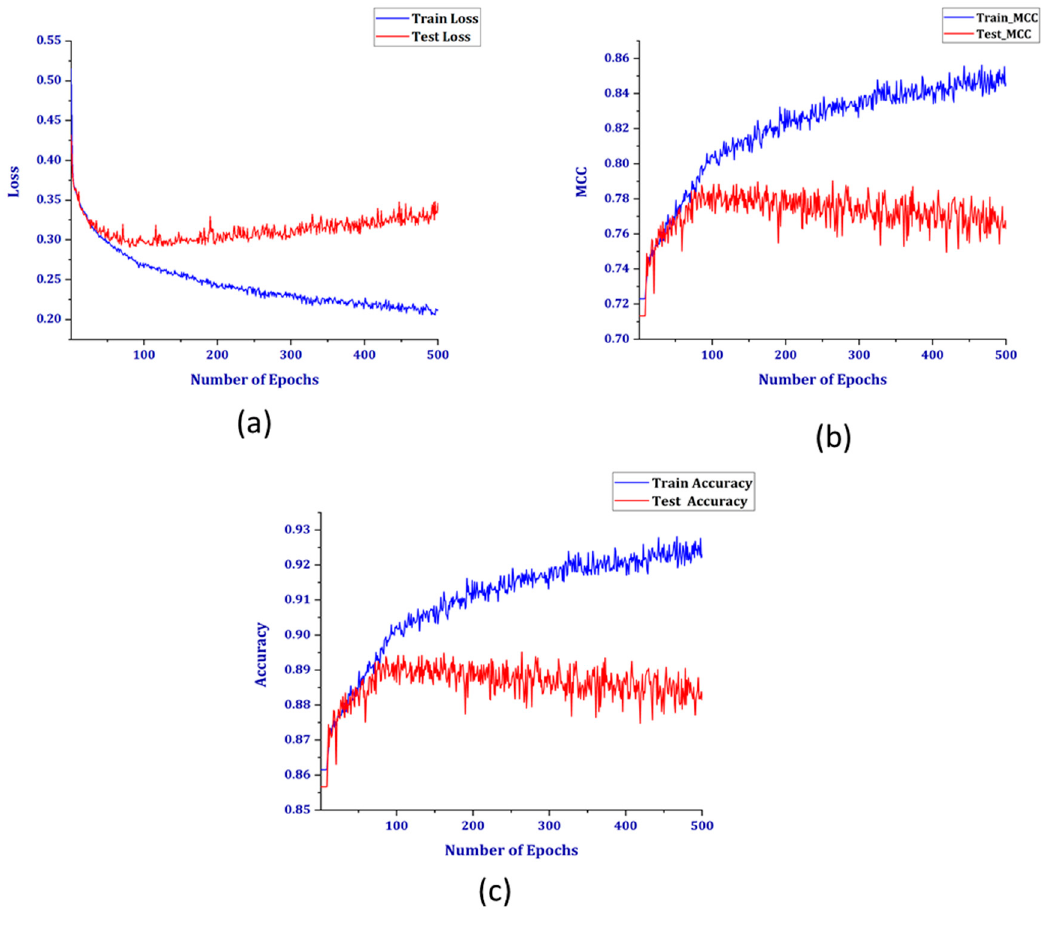
Figure 9. ( a ) Loss, ( b ) Matthews correlation coefficient (MCC), and ( c ) accuracy for the unbalanced dataset.